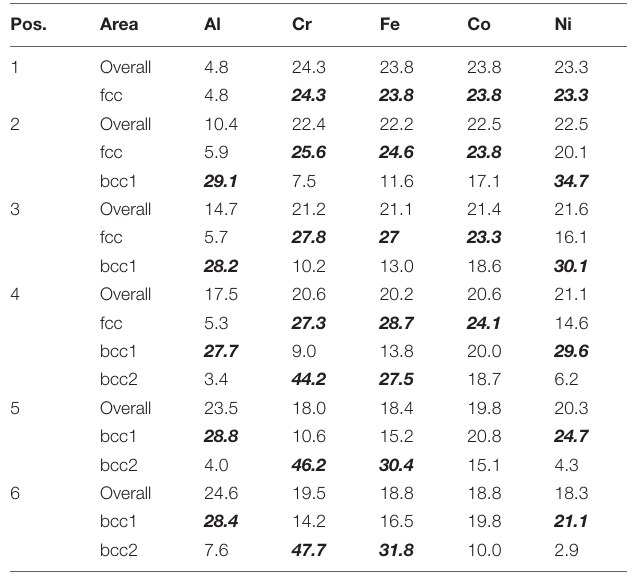
TABLE 4 | Representative EDS analysis of the major regions of the samples after heat treatment (at %). Pos.